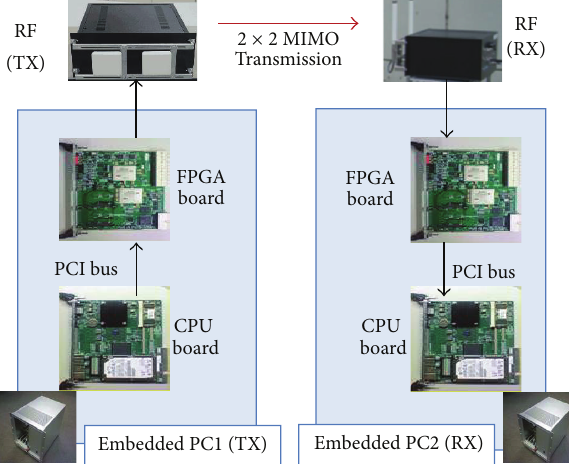
Figure 2: Structure of experimental platform for 2 × 2 MIMO- OFDM communication.